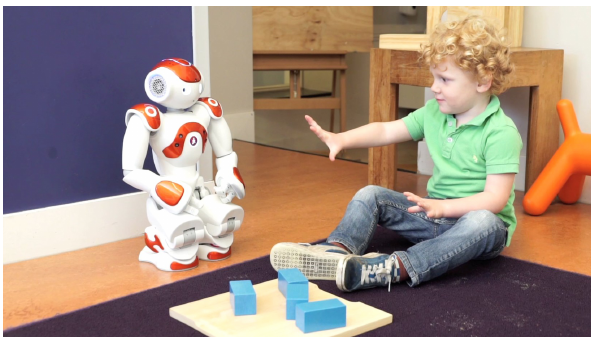
Figure 1. The setup of the